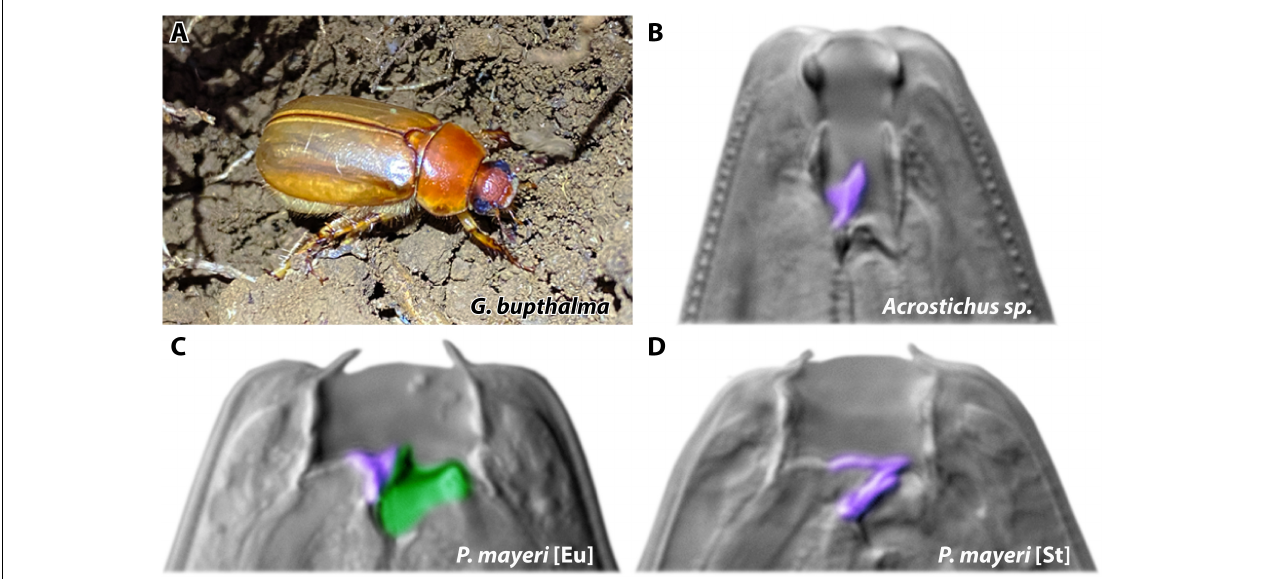
FIGURE 1 | Host beetle and mouth forms of symbiont nematodes. (A) Adult male beetle Gymnogaster bupthalma on La Réunion Island. Photo by Christian Weiler. (B–D) Dorsal tooth marked in purple, subventral in green. (B) Single-toothed Acrostichus is strictly bacterial-feeding. P. mayeri develops either (C) the wide predatory Eu morph with both the dorsal and subventral teeth or (D) the strict bacterial-feeding St morph with only the dorsal